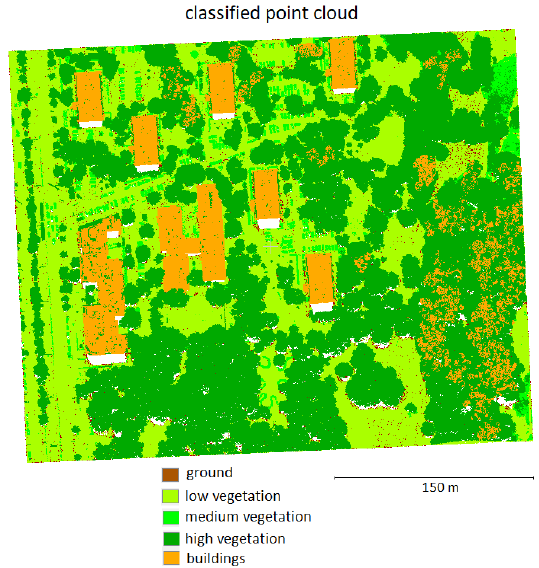
Fig. 3 Reslts of the classification in TerraScan. The asphalt was classified as low vegetation